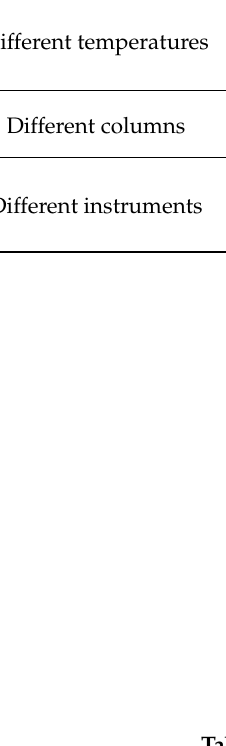
Table 6. The carotenoid contents in LB samples by using ESM and QAMS